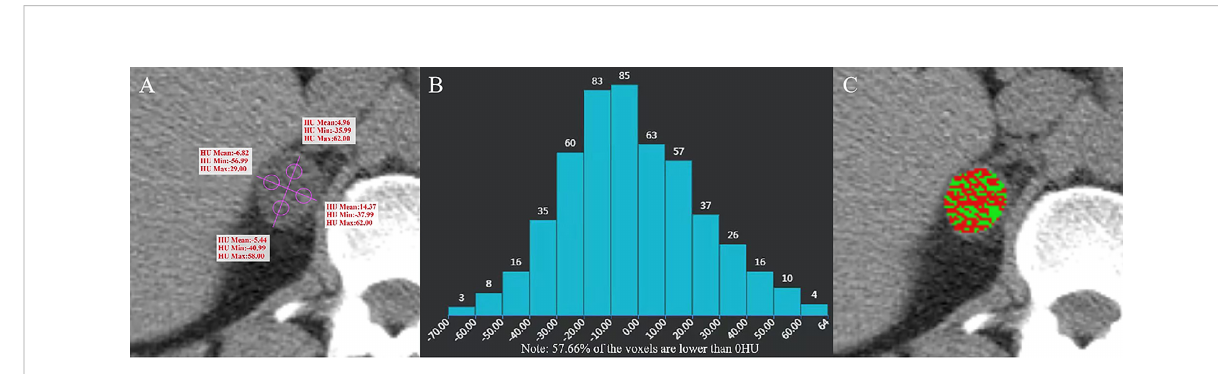
FIGURE 2 Adenoma of the right adrenal gland in a 47-year-old man. AVmean = 1.768 HU, AVmin = -42.99 HU (A) , and CTH negative pixels = 57.66% (B) . The CT value in the red area is ≤ 10 HU, and the CT value in the green area is > 10 HU (C)